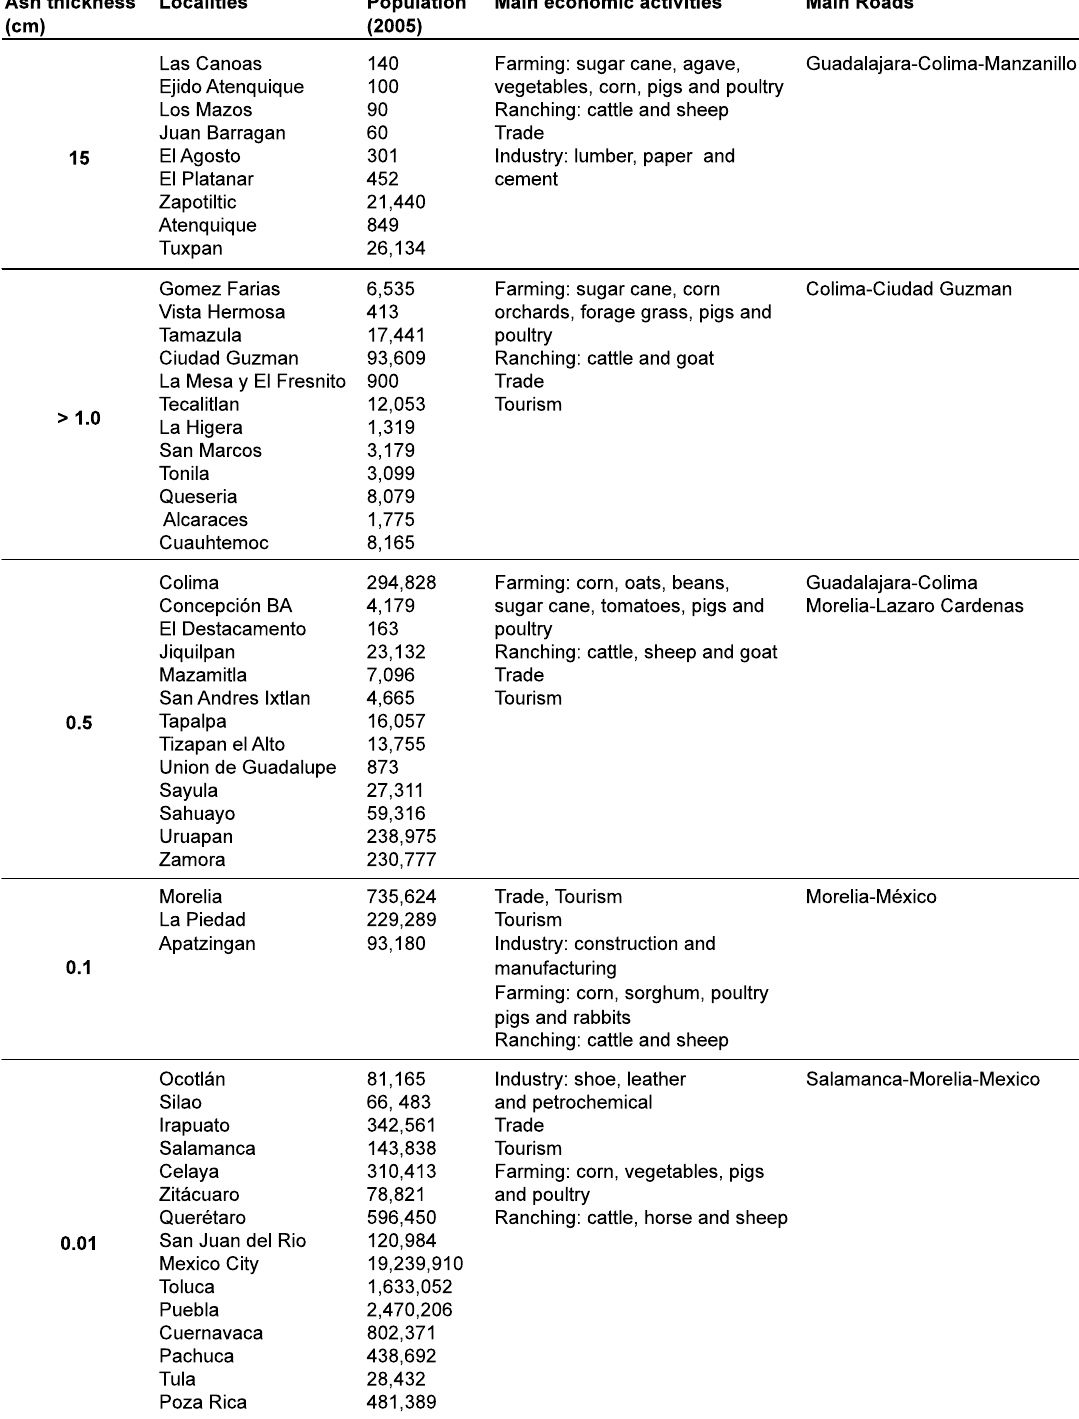
occurring from April and